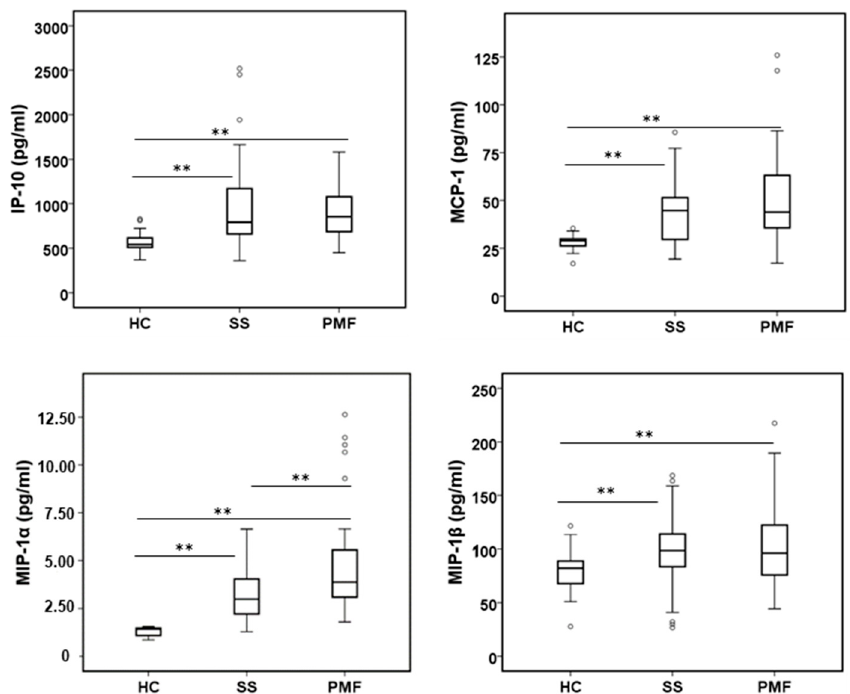
Figure 4. Levels of chemokines in plasma from peripheral blood were assayed in all participants. All chemokines were assayed by the Bio-Plex assay. ** indicate significance p < 0.01.